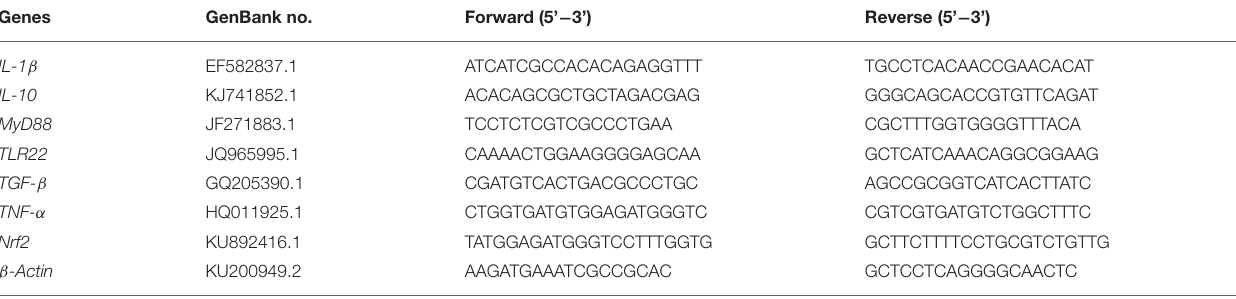
TABLE 3 | Sequence of primers used in this study.